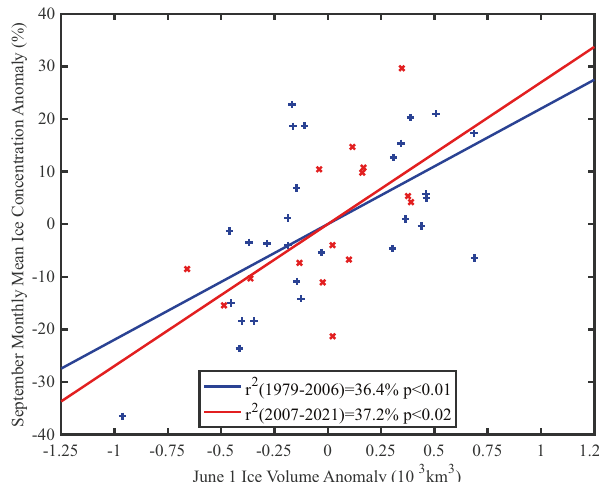
Fig. 9 Relationship between June 1 ice conditions and September mean ice concentration 1979 – 2021. Scatterplot of the June 1 PIOMAS ice volume anomaly and the NSIDC CDR September monthly mean ice concentration anomaly. Linear least squares fi t to the data for the two regimes are also shown as are the percentage of the variance explained. Both time series have been detrended by step functions with a breakpoint in